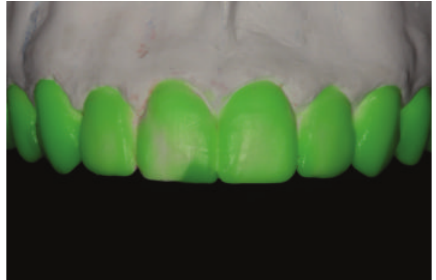
Figure 3: Final diagnostic appearance.